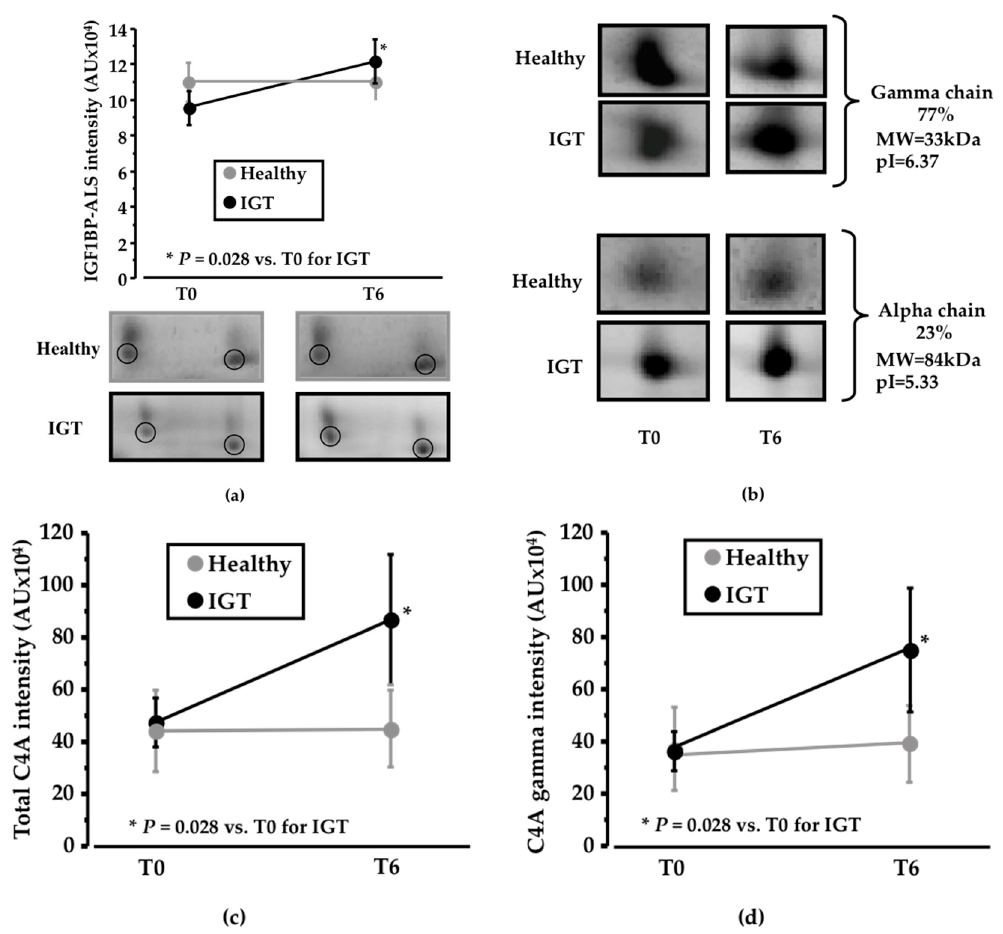
Figure 3. Changes in the proteomic profile. ( a ) Line diagram and representative 2-DE (two-dimension electrophoresis ) images showing IGF1BP-ALS ( Insulin-like growth factor-1 binding protein acid labile subunit ) change after six weeks of sucrose/pinitol-enriched beverage intake. Change in IGF1BP-ALS level was higher in IGT patients compared to healthy subjects ( N = 6; P = 0.200) is observed in IGT patients; ( b ) Representative 2-DE images of C4A complement alpha and gamma chain. Alpha chain corresponds to the 27% of the total C4A complement identified complement. Gamma chain represents the 77% of the total C4A complement identified protein ( c ) Line diagram showing total C4A complement change of both healthy and IGT volunteers after the intake of the pinitol-enriched beverage. A significant change increase of the C4A complement level ( N = 6; P = 0.02) is observed on IGT patients; ( d ) Line diagram showing C4A complement gamma chain of both healthy and IGT volunteers after the intake of the pinitol-enriched beverage. A significant change increase of C4A complement level ( N = 6; P = 0.02) is observed in IGT patients.